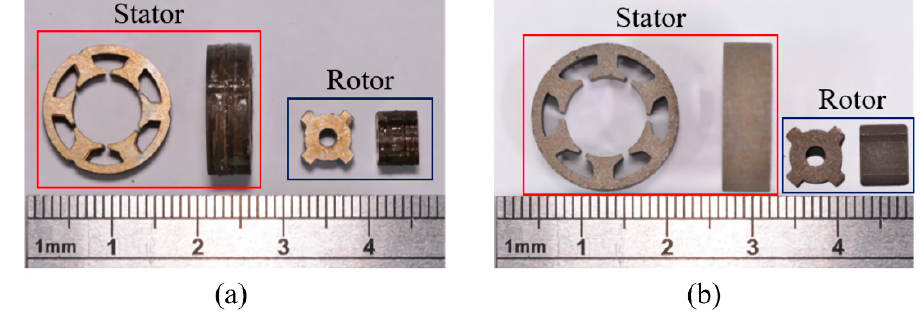
Figure 9. Stator and rotor cores made of ( a ) 35CS300 and ( b ) Somaloy 700 1P .